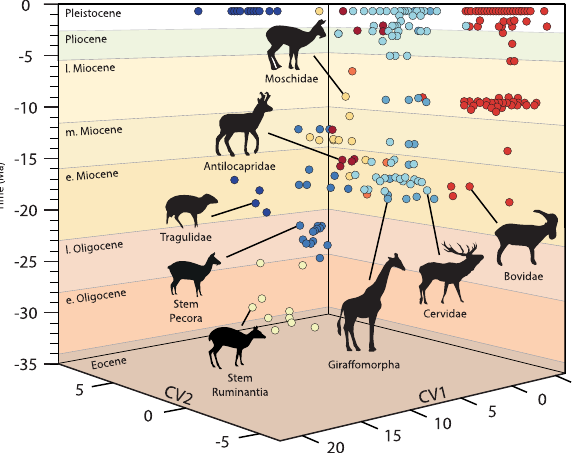
Fig.1|Evolutionofruminantbonylabyrinthmorphologythroughtime. Shape changes are observed along CV axes (CV1 45.23% & CV2 16.84%). Groups are Stem Ruminantia (light yellow), Tragulidae (dark blue), Stem Pecora (light dark blue), Antilocapridae (dark red), Dromomerycidae (orange), Giraffomorpha (dark light blue),Cervidae(lightblue),Moschidae(yellow),andBovidae(red).Bivariateplotof CV1 vs CV2 and animated gif of the Fig. 2 can be found in Supplementary Data 1. Thickened circles are the bony labyrinth specimens from Supplementary Fig. 3. Silhouettes of the families modi fi ed from ref.